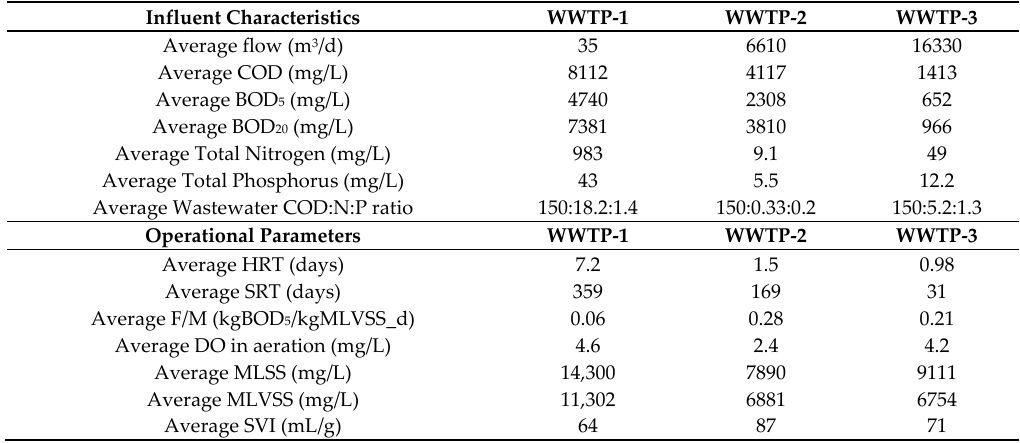
Table 1. Influent characteristics and operational parameters of the three studied